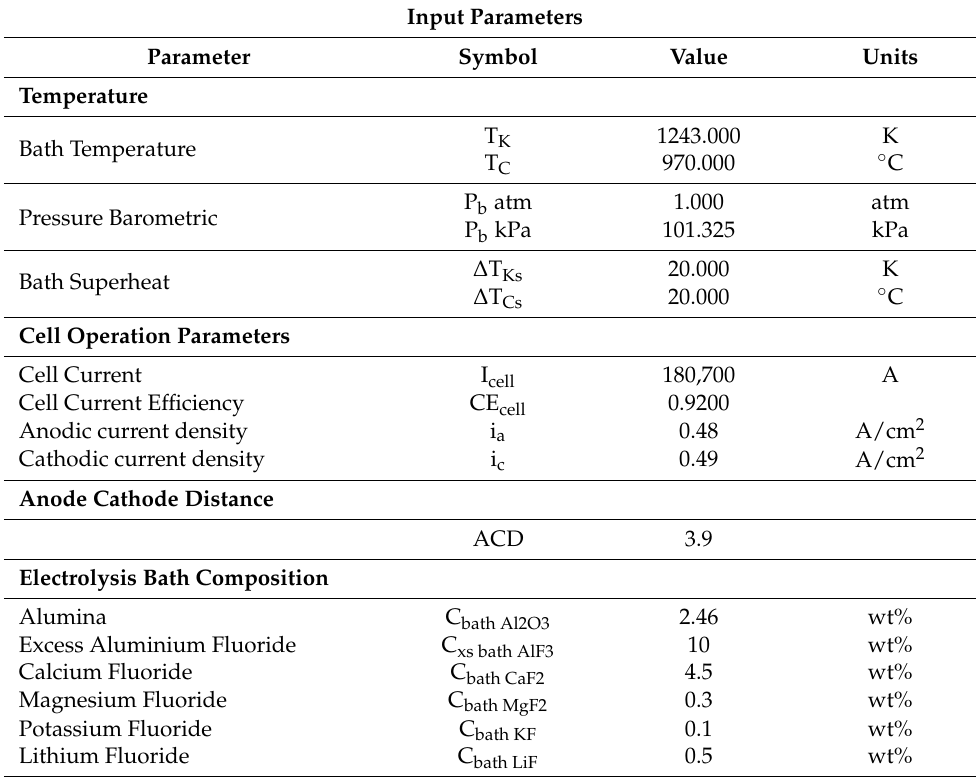
Table 1. Input parameters for the Hall–Heroult Electrolysis Cell Energy Balance model.